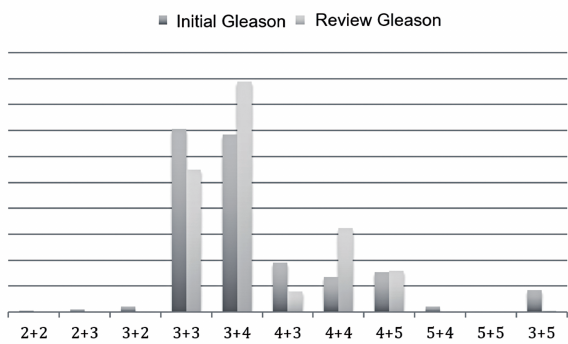
Figure 1 - Initial and post - review GS of all